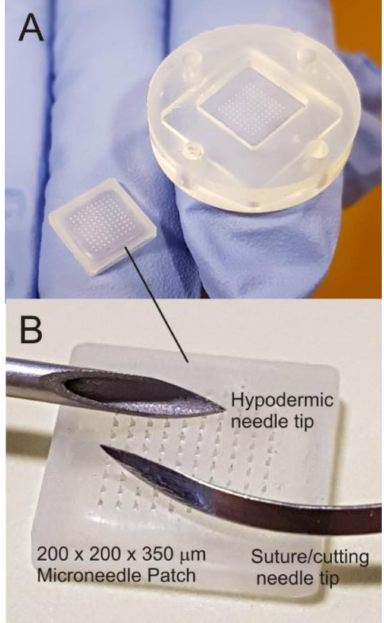
Figure 1. ( A ) Micropoint™ 200 × 200 × 350 microneedle (MN) mould template and an example of the resulting polymer cast MN patch. ( B ) Comparison of sharp